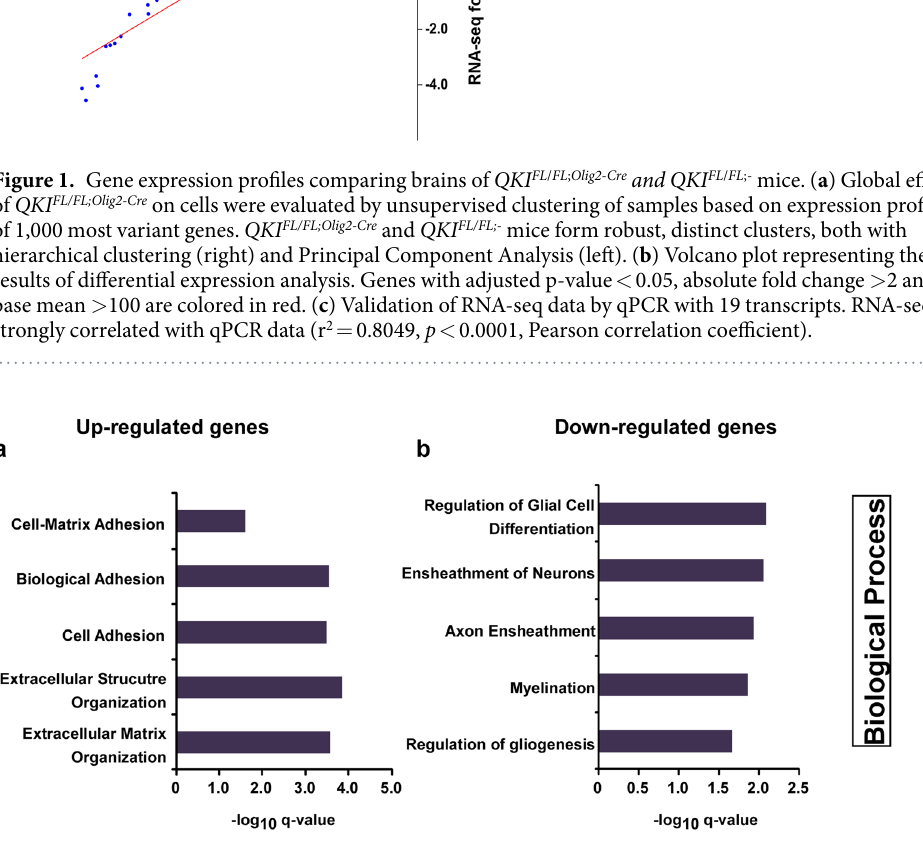
Figure 2. Gene ontology analysis. Gene Ontology analysis shows enriched Biological Processes in the lists of upregulated genes (a) and downregulated genes (b) in QKI FL/FL;Olig2-Cre mice. Genes with adjusted p-value < 0.05, absolute fold change > 2 and a base mean > 100 were used for the